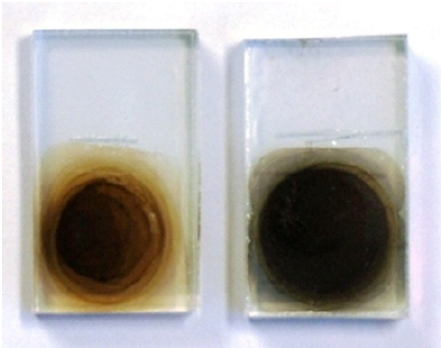
Figure 3. Photo-images of GO (left) and erGO (right). Figure 2. Linear sweep voltammogram of GO (red) (supporting electrolyte: 0.5 M Et 4 NBF 4 in pro- pylene carbonate). As a reference, the LSV curve of bare FTO is shown (blue).